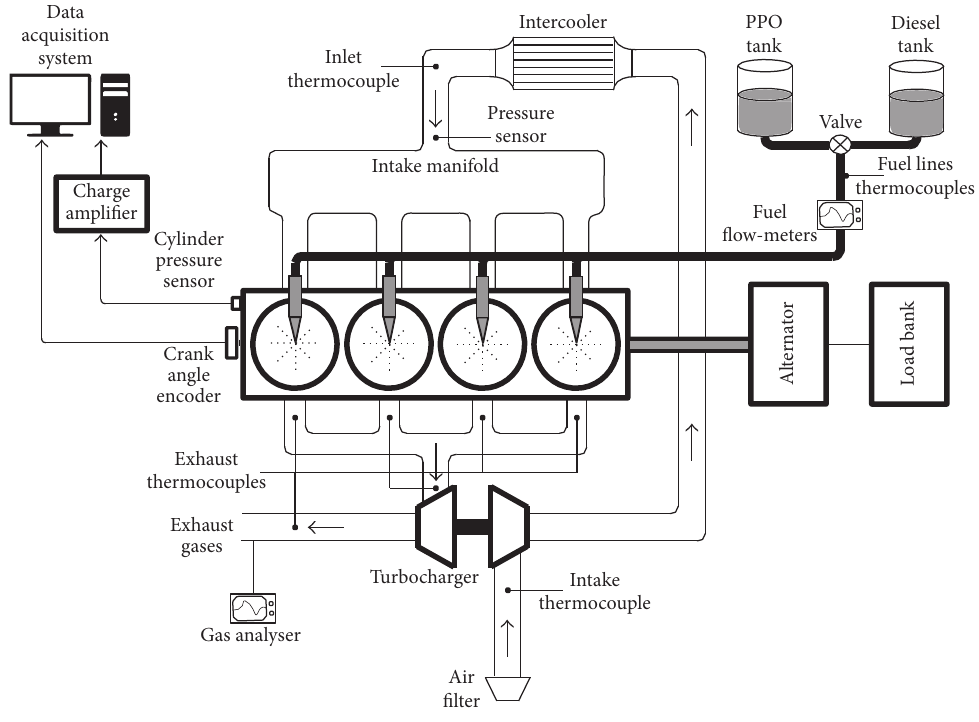
Figure 1: Schematic layout of the experimental setup.